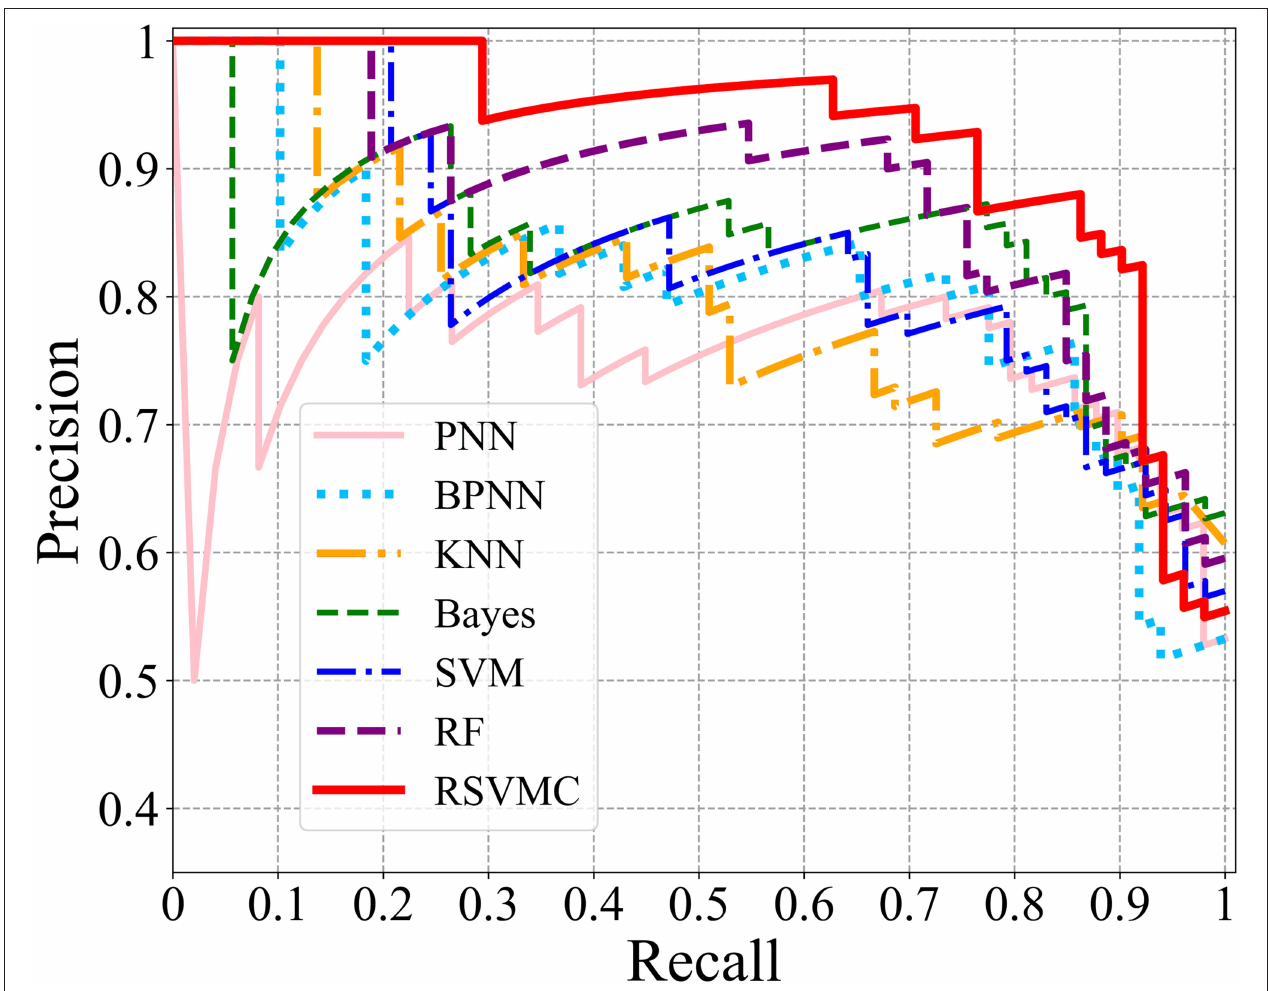
FIGURE 3 | The P-R curves of comparative